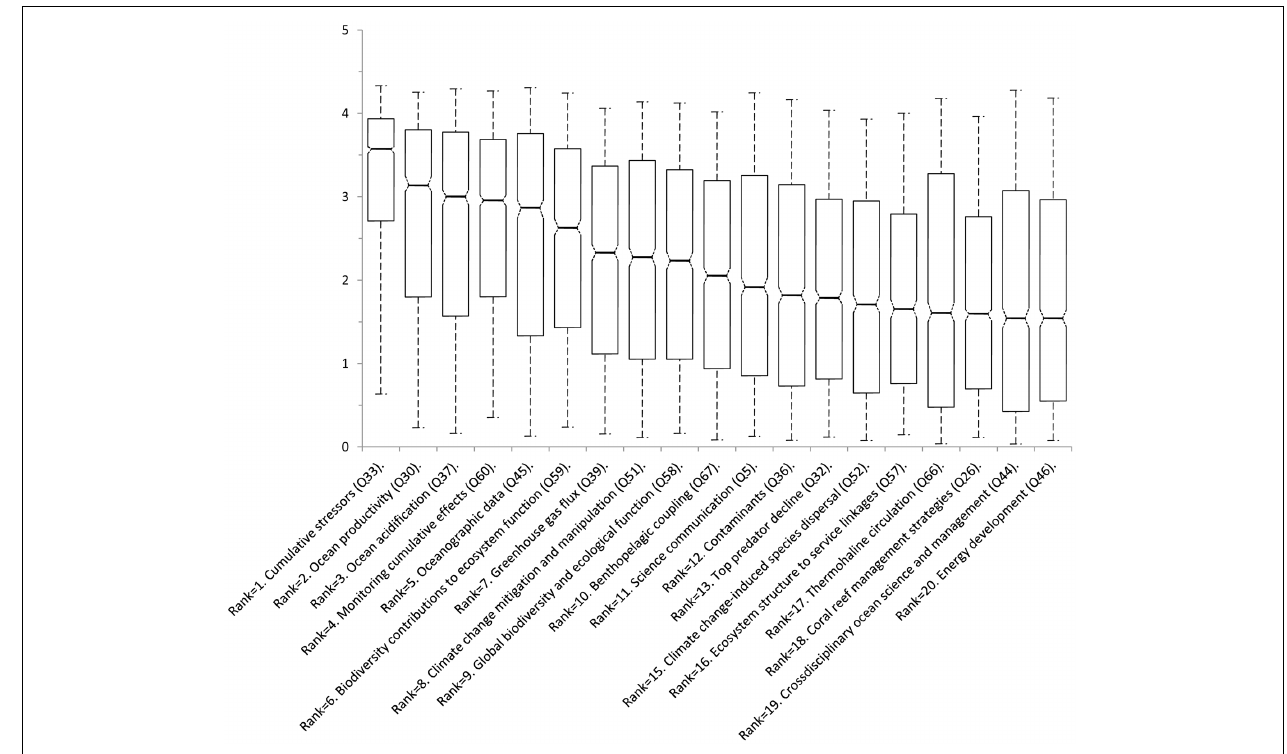
FIGURE 1 | Box plot of median ranking score for the 20 research questions ranked, in aggregate, as highest priority.